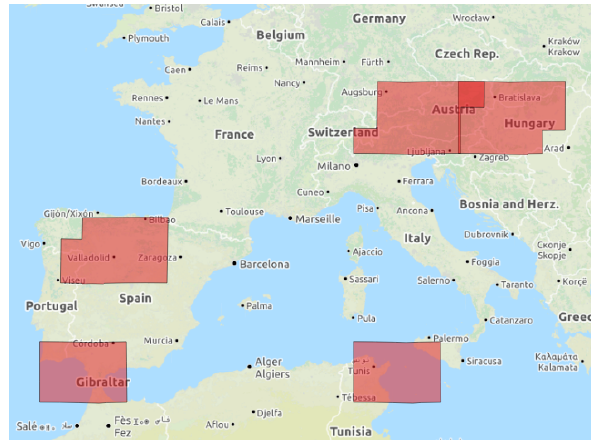
Figure 5: Source image locations. Background map: c (cid:13) O PEN S TREET M AP contributors, available under the O PEN D ATABASE L ICENSE